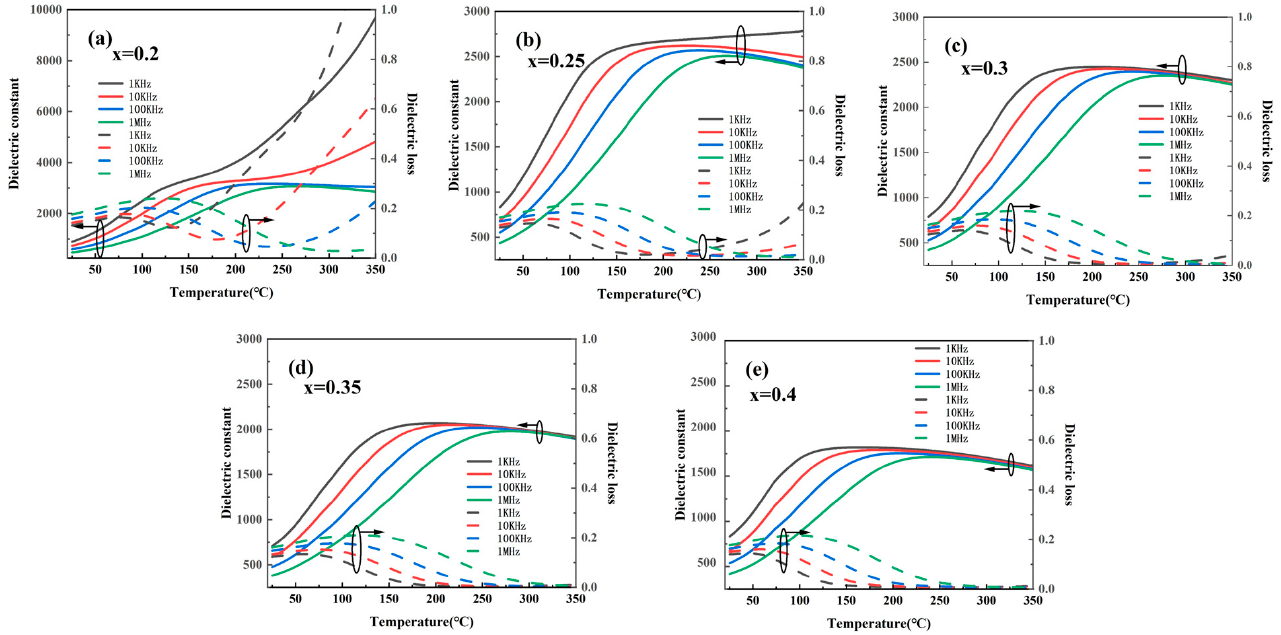
Figure 3. Dielectric temperature spectra of the (0.4 − x)BF-xBMT-0.6BT bulk ceramics with various frequencies: ( a ) x = 0.2; ( b ) x = 0.25; ( c ) x = 0.3; ( d ) x = 0.35; ( e ) x = 0.4.